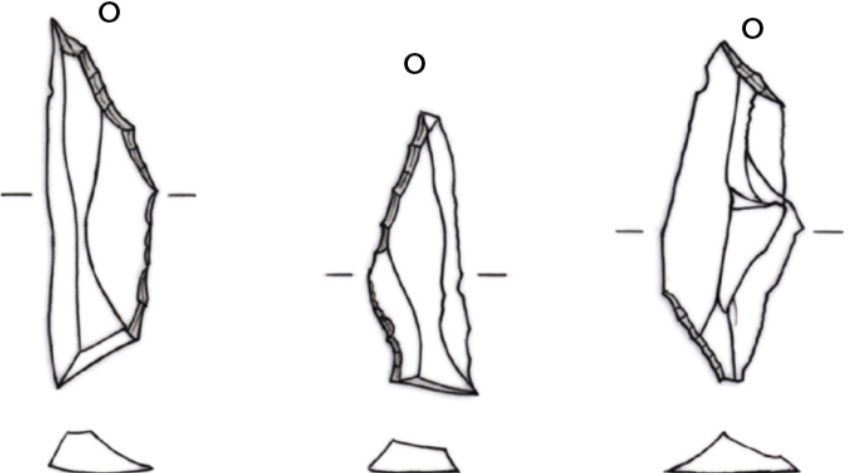
Figure 9. Angle-backed and rhomboid points from Nethermills Farm (CAT 78/802: length 26mm; 80/808: length 21mm; 79/354: length